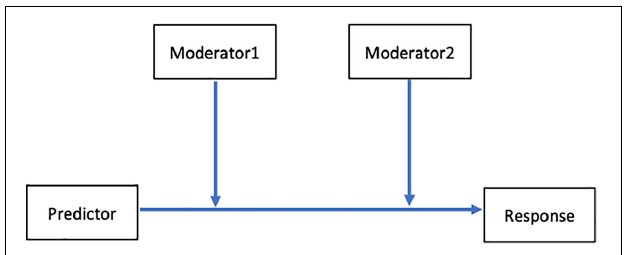
FIGURE 1 | Depiction of analysis using Hayes’ (2017) PROCESS model